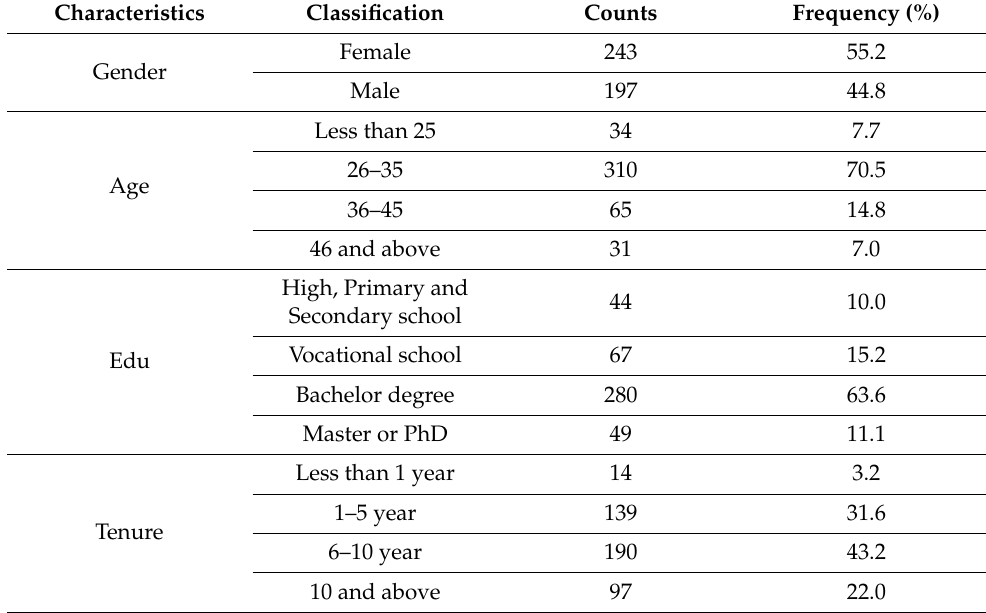
Table 1. Sample characteristics (N =